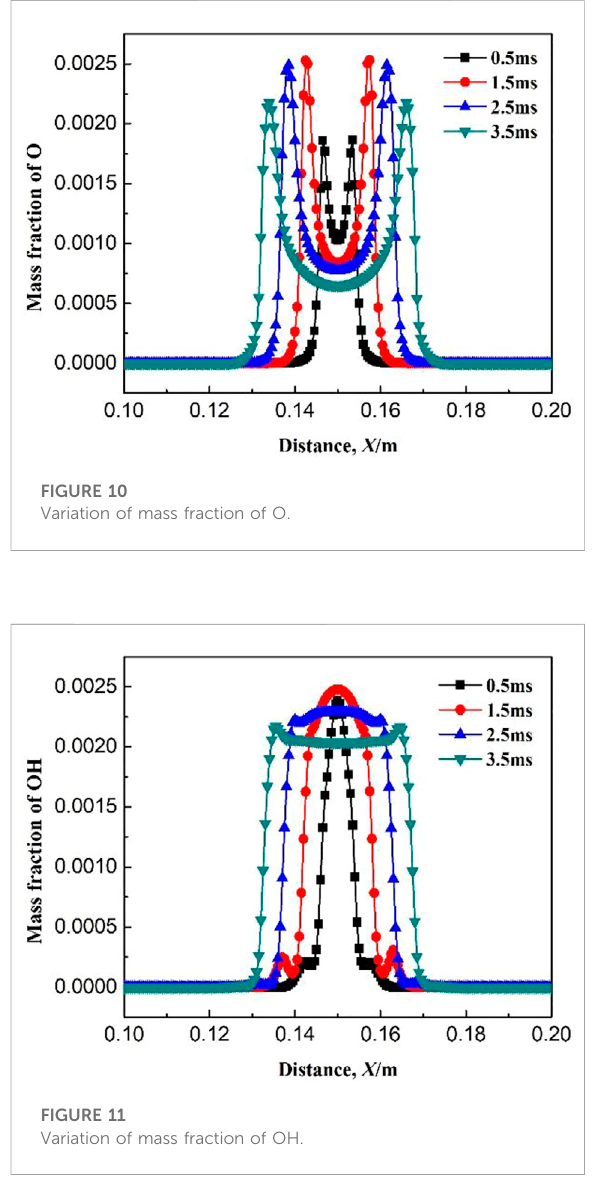
FIGURE 11 Variation of mass fraction of OH.